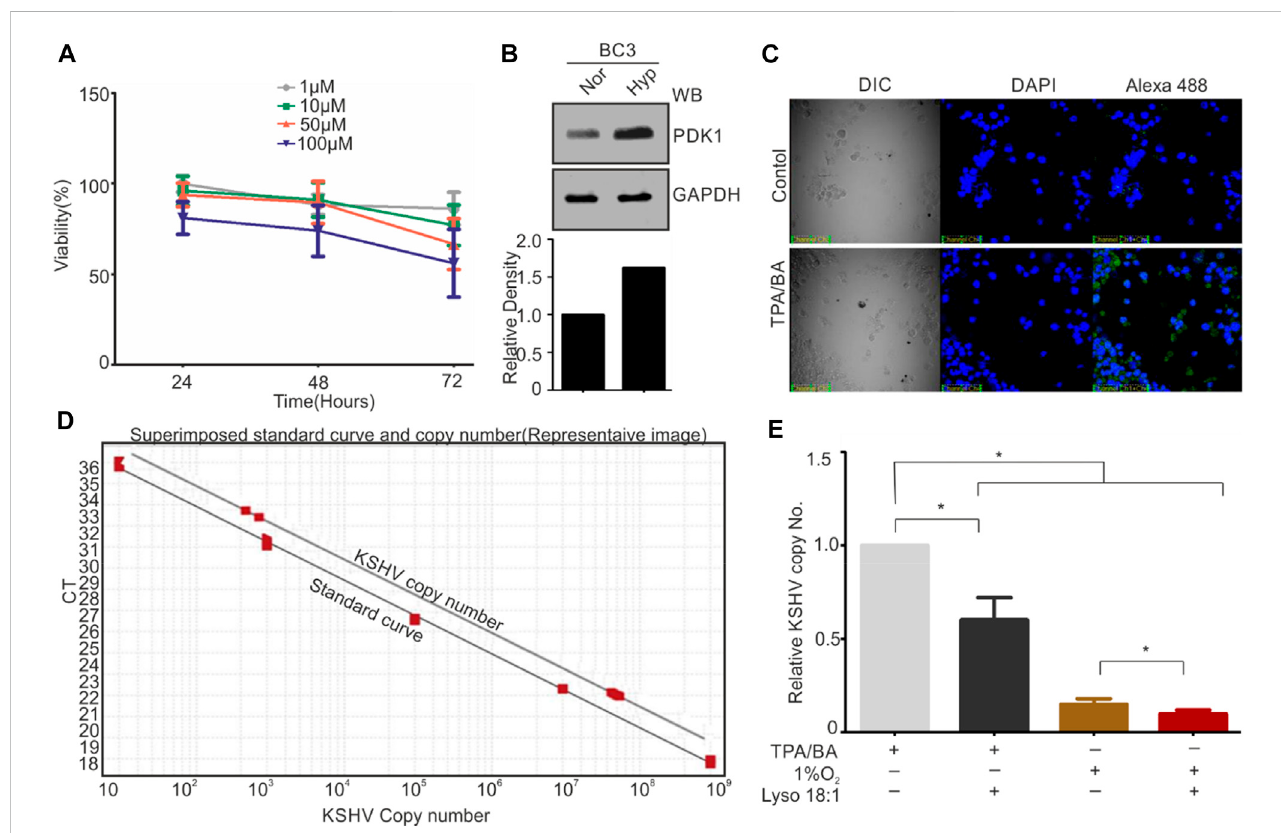
FIGURE 5 LPA inhibitsKSHV production of KSHV virions from reactivated cells. (A) Cell viability testin different concentration ofLPA. Cells weregrown in presence of different concentration of LPA for the indicated time periods. Viability of cells was checked by Trypan blue staining. Mean value of viable cells from three independent experiments are shown. (B) Induction of hypoxia during hypoxic reactivation was con fi rmed by PDK1 Western blot. GAPDH served as loading control. (C) TPA/BA mediated reactivation of BC3 cells was con fi rmed by RTA immuno fl uorescence. (D) Standard curve for various KSHV copy number plasmids superimposed with curve for KSHV copy number calculation. (E) Relative KSHV copy number from extracellular medium of TPA/BA or hypoxia reactivated cells as compared with or without LPA